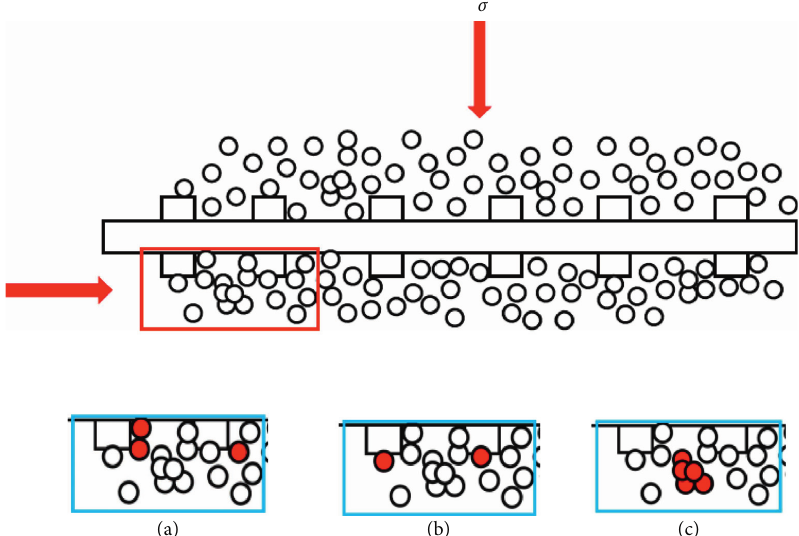
Figure 12: Stress diagram of soil particles in the shear process. (a) Passive friction resistance. (b) Bite force. (c) Friction shear